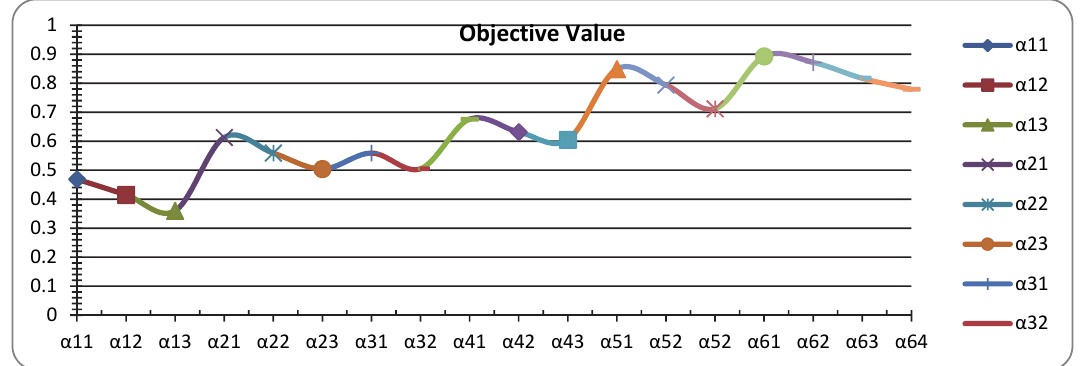
Fig. 4. Objective coefficients for the problem with different objective